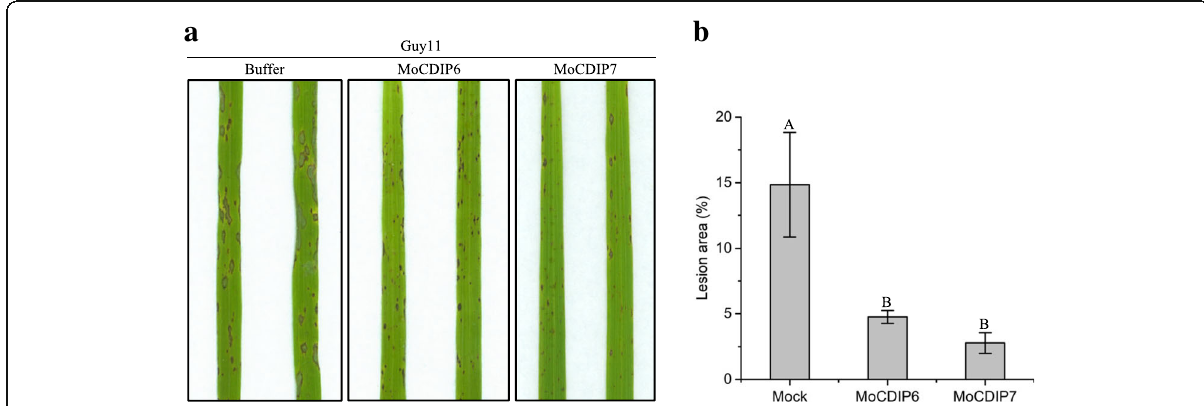
Fig. 6 Pretreatment with recombinant MoCDIP6 or MoCDIP7 enhanced rice resistance against M. oryzae . a Disease symptoms on leaves of Nipponbare rice seedlings inoculated with a virulent M. oryzae isolate Guy11 with a 24-h pretreatment with recombinant MoCDIP 6 or MoCDIP7 (2 μ M). b Disease lesion areas on leaves of MoCDIP6- or MoCDIP7-pretreated rice seedlings inoculated with Guy11. A and B indicate the significant differences according to LSD multiple range test at P ≤